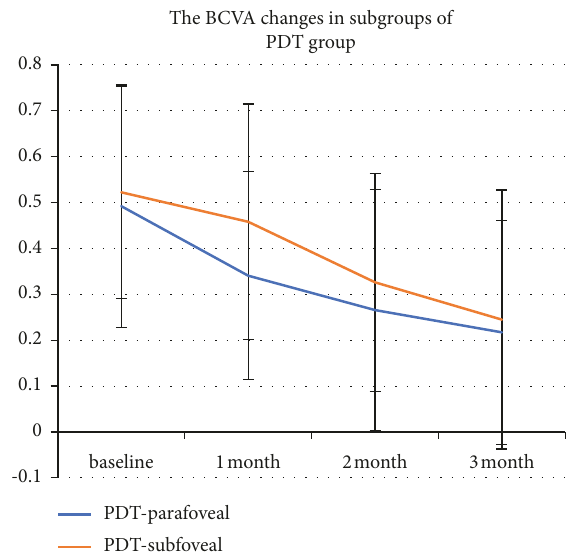
Figure 4: Best-corrected visual acuity (BCVA) changes in the parafoveal and subfoveal subgroups in half-dose PDT. The BCVA at the baseline and 1, 2, and 3 months during the follow-up period is shown in this figure. The parafoveal and subfoveal subgroups in the PDT group analysis revealed that the treatment could improve visual outcomes. The change in BCVA in the PDT-subfoveal group was defined with a red line chart, while the change in BCVA in the parafoveal group was defined with a blue line chart ( P 0.107; 0.368; 0.691).